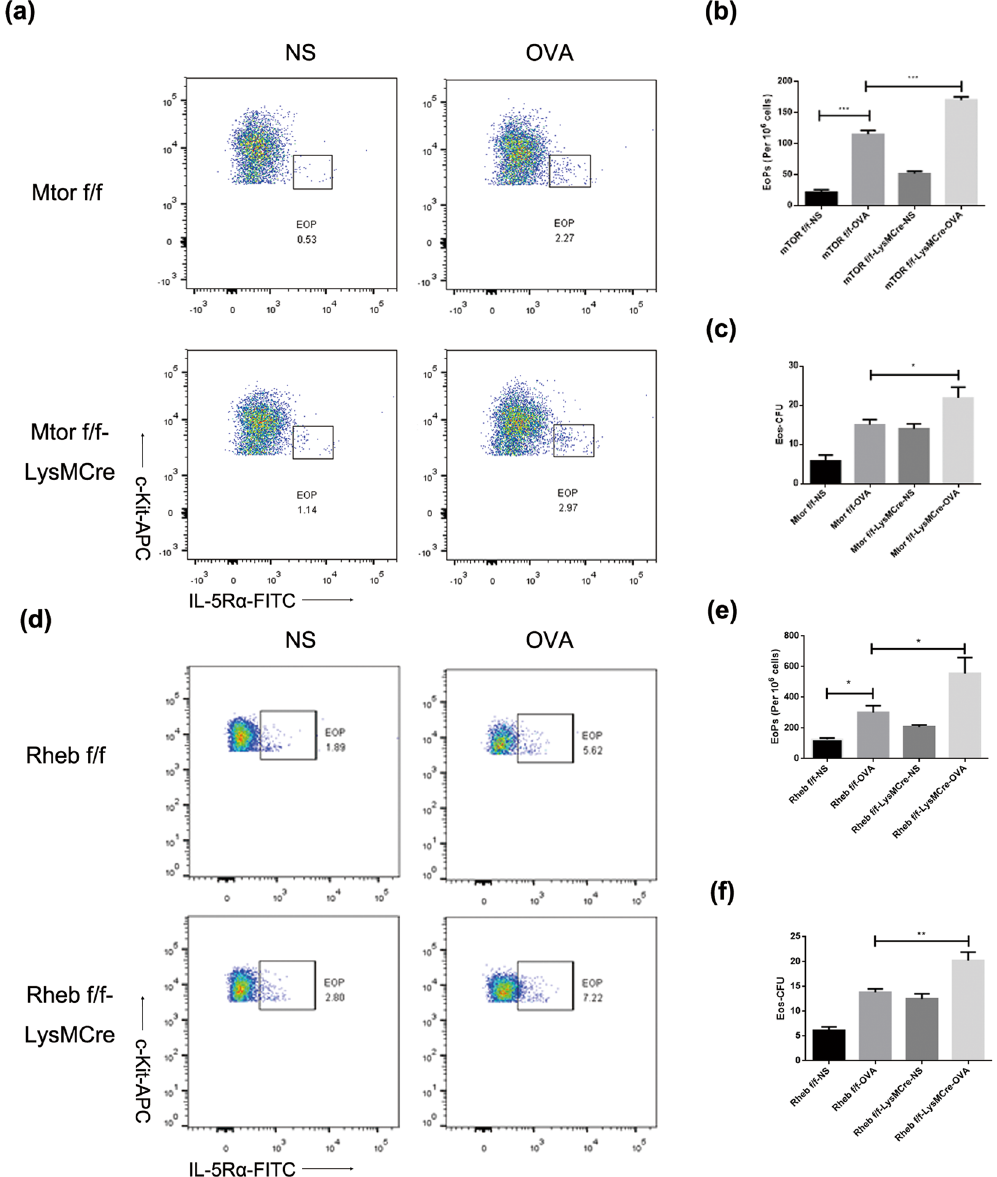
Figure 4. Myeloid specific deletion of mTOR leads to increased level of Eops. ( a ) Eops were identified as c-Kit + IL-5Ra + cells in alive Lineage − CD34 + CD16/32 + subsets. Representative contour plots of staining were shown using allergic LysM Cre Mtor flox/flox mice (n = 5 per group). ( b ) Number of Eops per 10 6 cells were statistically calculated as means ± SEM. ( c ) Bone marrows of allergic mice were harvested and colony formation was performed to verify Eops number. ( d ) LysM Cre Rheb flox/flox mice were used to establish OVA-induced asthma model, Eops numbers were detected as previously described. ( e ) Statistical results of Eops in allergic Rheb knockout mice in per 10 6 cells. ( f ) CFUs of allergic Rheb genetic deletion mice. Results were analysed as means ± SEM. All the results above were repeated by three independent experiments. * P < 0.05, ** P < 0.01, *** P <